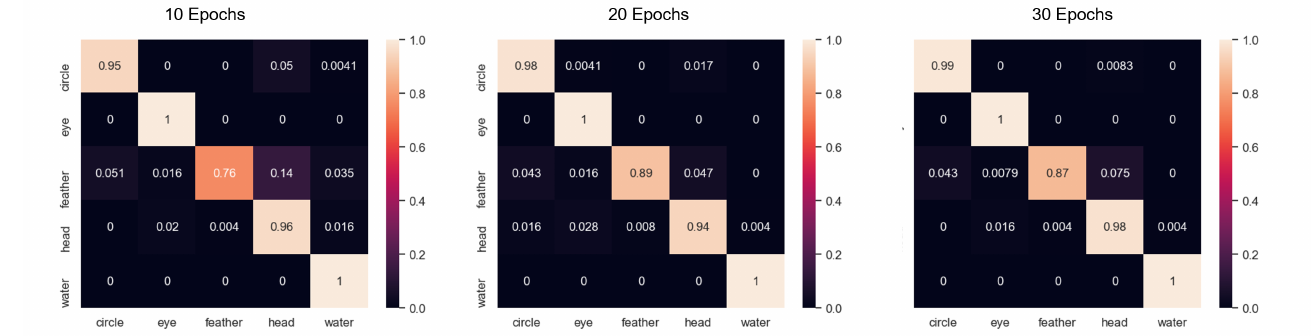
Figure 9. Confusion matrices of the trained CNN for 10, 20, and 30 epochs,